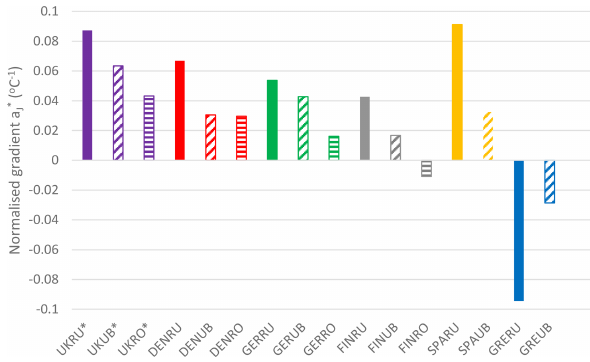
Figure 6. Normalised gradients a ∗